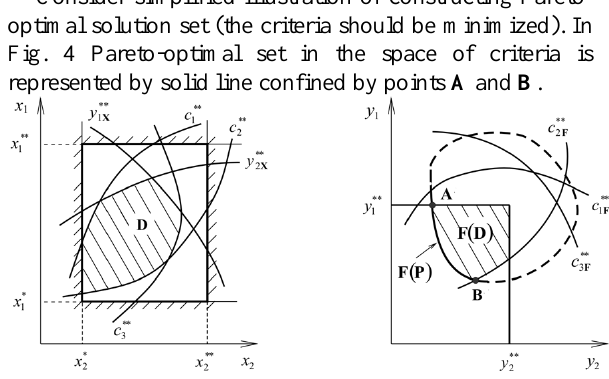
Fig. 4 Pareto-optimal set in the space of criteria is represented by solid line confined by points A and B .